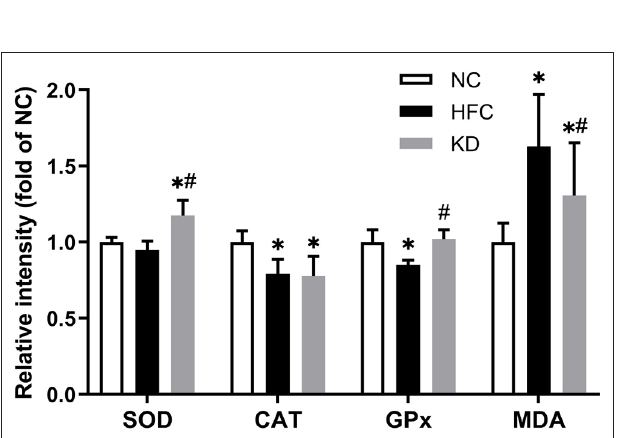
FIGURE 6 | Effects of a high-fat and high-cholesterol diet and a ketogenic diet on testicular antioxidants [superoxide dismutase (SOD), catalase (CAT) and glutathione peroxidase (GPx) activity] and MDA content in male mice. Data are expressed as the mean ± SD. * p < 0.05, compared with the NC group; # p < 0.05, compared with the HFC group. NC, normal diet; HFC, high-fat and high-cholesterol diet; KD, HFC diet changed to MCT-based ketogenic